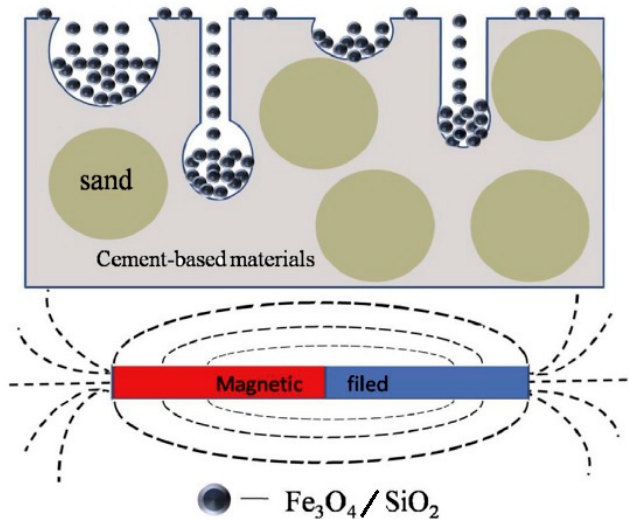
Figure 21. A schematic illustration of the surface treatment process of Fe 3 O 4 /SiO 2 nanoparticles under a magnetic field (Reprinted with permission from [104]. Copyright 2017 Elsevier).